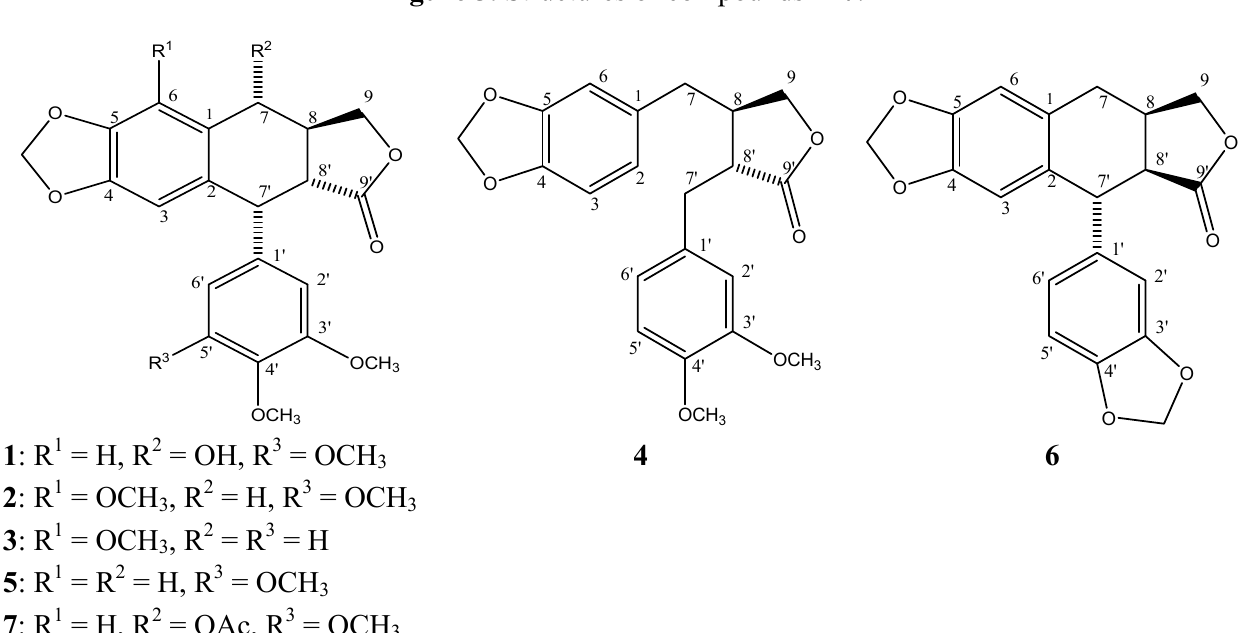
Figure 3. Structures of compounds 1 – 7